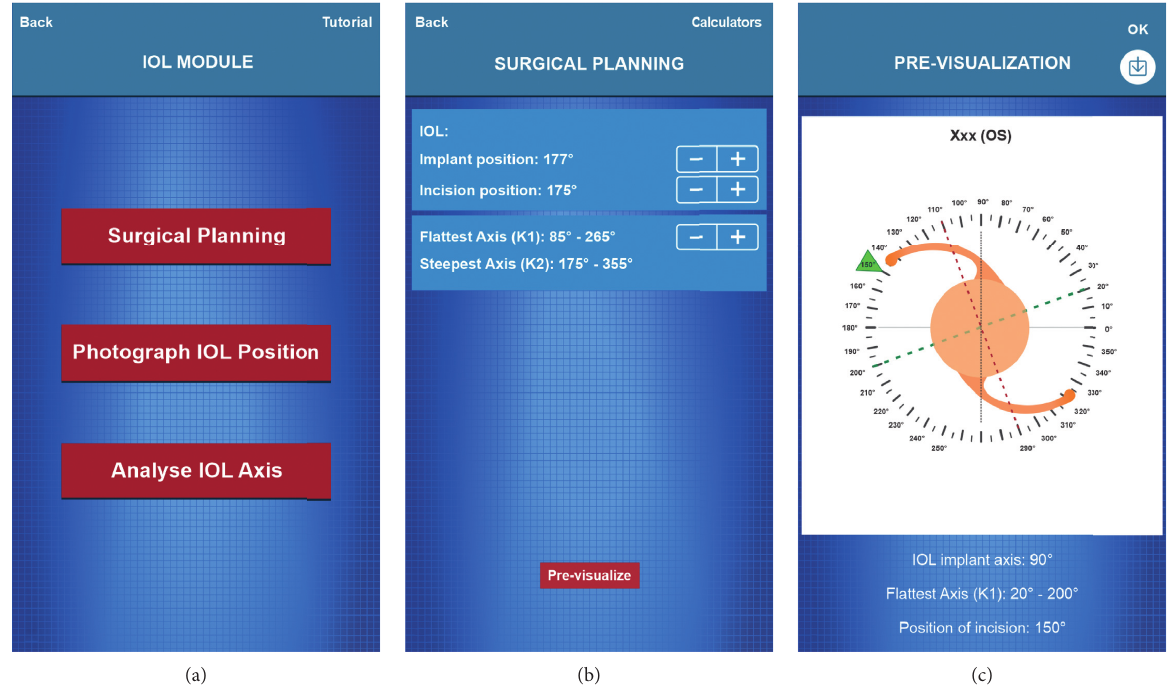
Figure 2: (a) Screen for access to the surgical planning and tutorial screens. (b) Surgical Planning screen. (c) Pre-visualization of surgical planning. The user can record the image for later overlay of images at the end of the procedure, providing a way to assess the measurements.